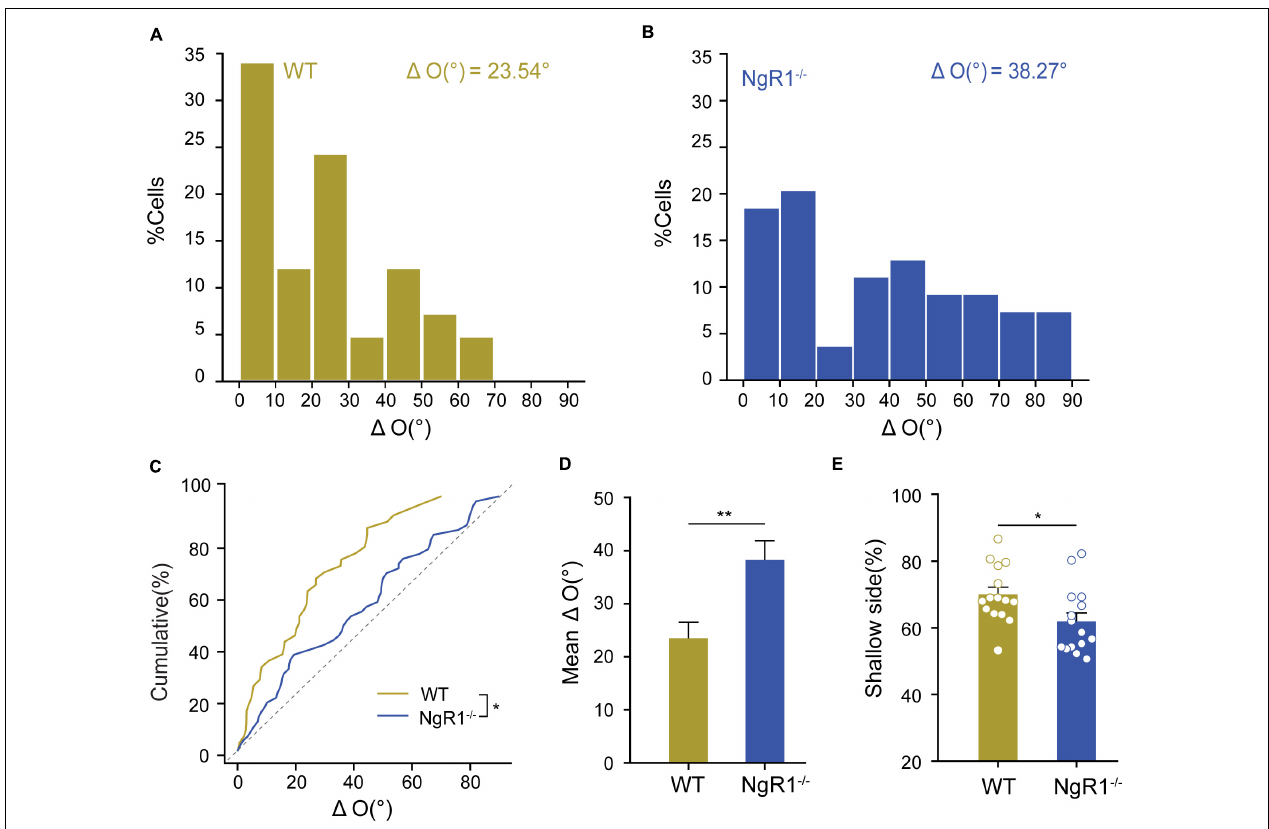
FIGURE 10 | NgR1 − / − disrupts normal maturation of binocular matching and depth perception. (A,B) Distribution of interocular difference of preferred orientation (“ (cid:49) O”) in wild-type (WT) and NgR1 − / − groups: (A) WT ( (cid:49) O = 23.53 ± 2.97 ◦ , 41 cells, five mice); (B) NgR1 − / − mice ( (cid:49) O = 38.27 ± 3.59 ◦ , 54 cells, six mice). (C) Cumulative distribution of (cid:49) O for Veh and NgR1 − / − groups ( p = 0.020, K-S test). (D) Mean (cid:49) O for two groups ( p = 0.0094, Mann-Whitney rank-sum test). (E) WT animals spent a higher percentage of time on the safe side with respect to NgR1 − / − mice (15 mice per group, p = 0.032, unpaired t -test). Each circle indicates individual mouse. Data were expressed as mean ± SEM. * p < 0.05, ** p <